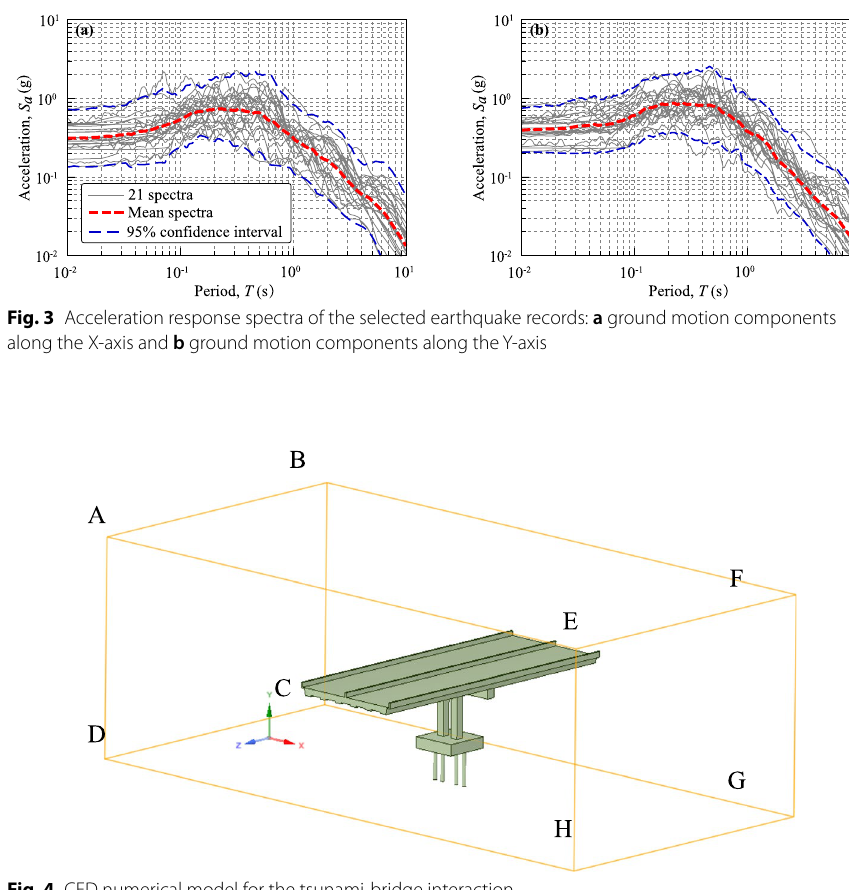
Fig. 4 CFD numerical model for the tsunami-bridge